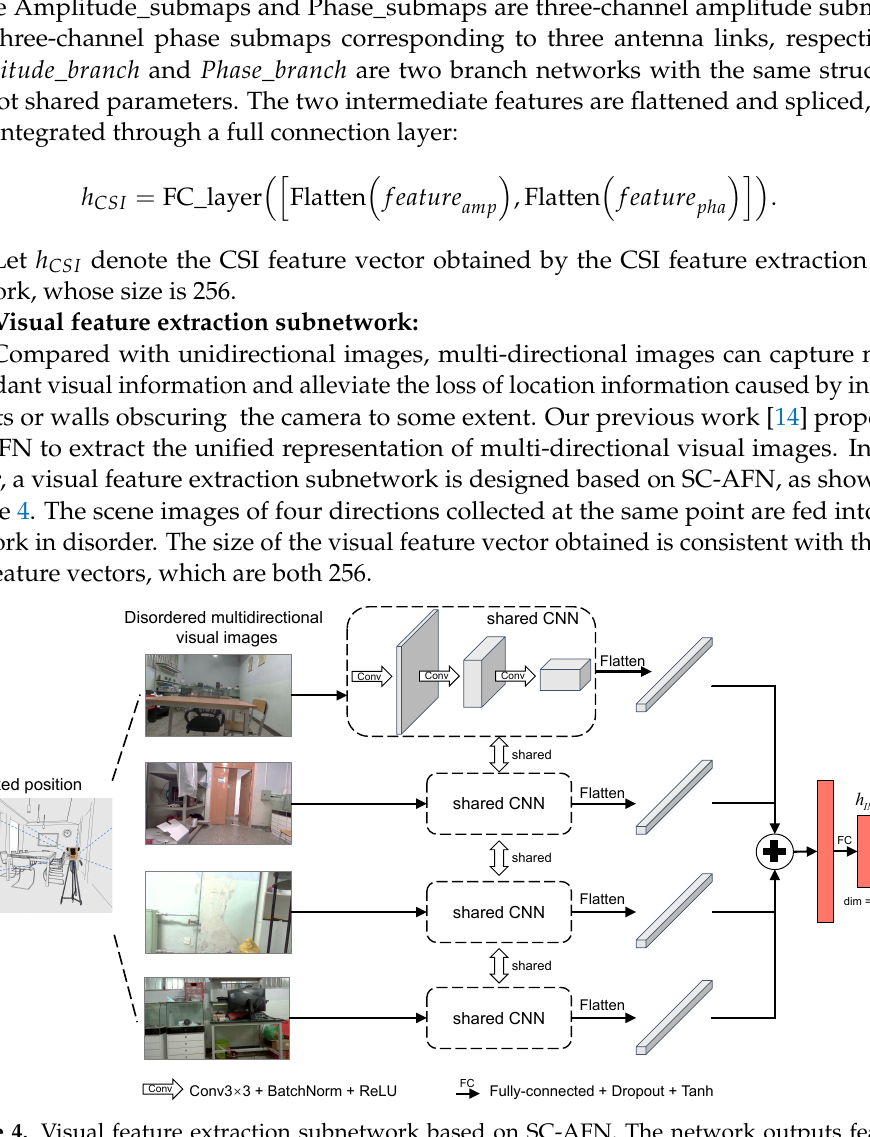
Figure 4. Visual feature extraction subnetwork based on SC-AFN. The network outputs feature vectors that contain specific location information of the visual